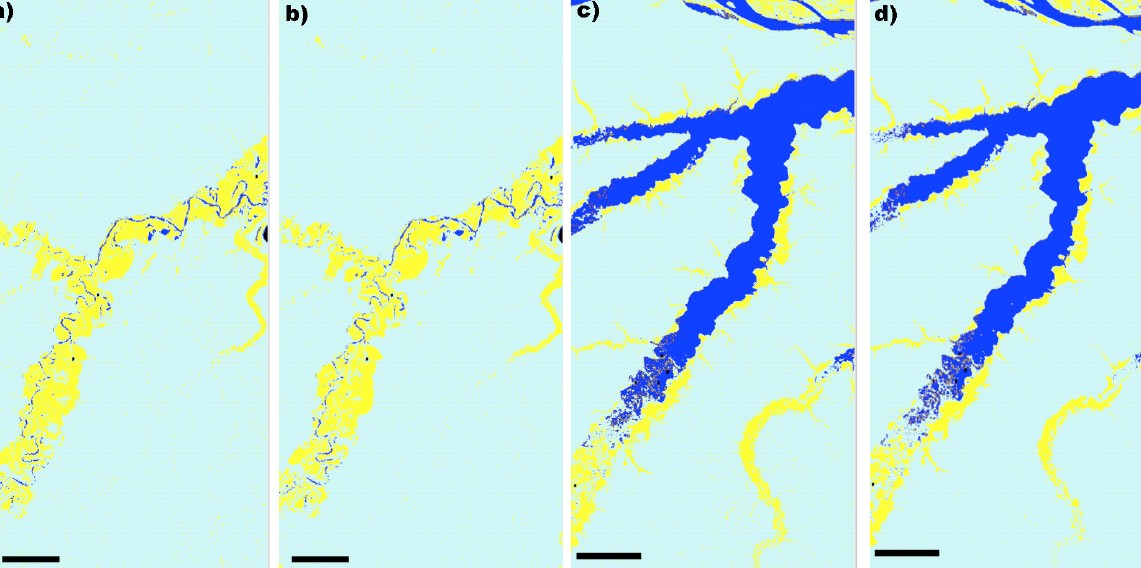
Figure 6. Black bar indicates 10 km scale. ( a ) Mid-swath classification from 27 June 2007 (coordinate: − 5.98°, − 64.83° shown by “x” in Figure 3); ( b ) near-swath classification from 22 June 2007; ( c ) mid-swath classification from June 27, 2007 (coordinate − 4.13°, − 63.42° shown by “y” in Figure 3); ( d ) far-swath classification from 22 June 2007. Yellow indicates inundated vegetation and dark blue indicates open water. All other areas are